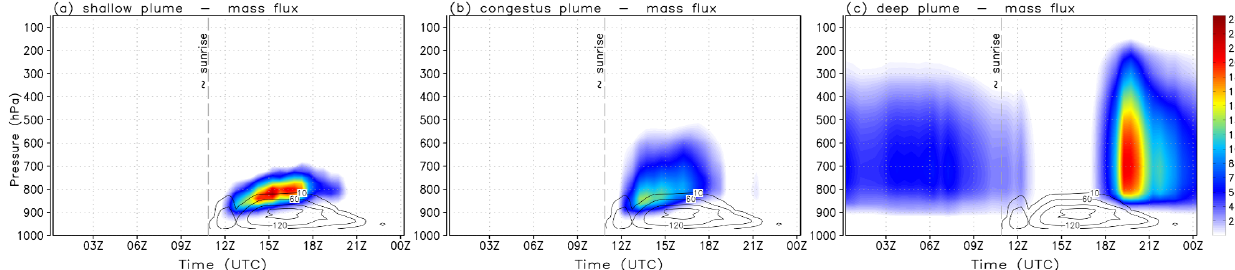
Figure 8. The diurnal cycle of the three convective modes as represented by the GF convection parameterization in a single-column model experiment with the GEOS-5 modeling system. The black contours represent the vertical diffusivity coefficient for heat (m 2 s − 1 ). The color contours show the updraft mass flux expressed in 10 − 3 kgm − 2 s − 1 .